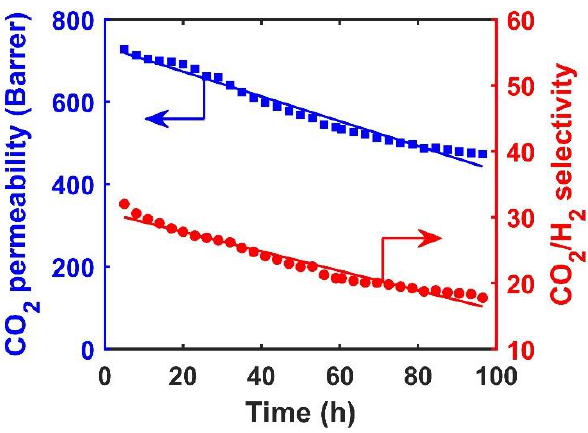
Figure 9. Transport performance of membrane without AF-MWNTs at 107 °C and 1.5-MPa feed pressure over a course of 100 h: CO 2 permeability ( ) and CO 2 /H 2 selectivity ( ● ).